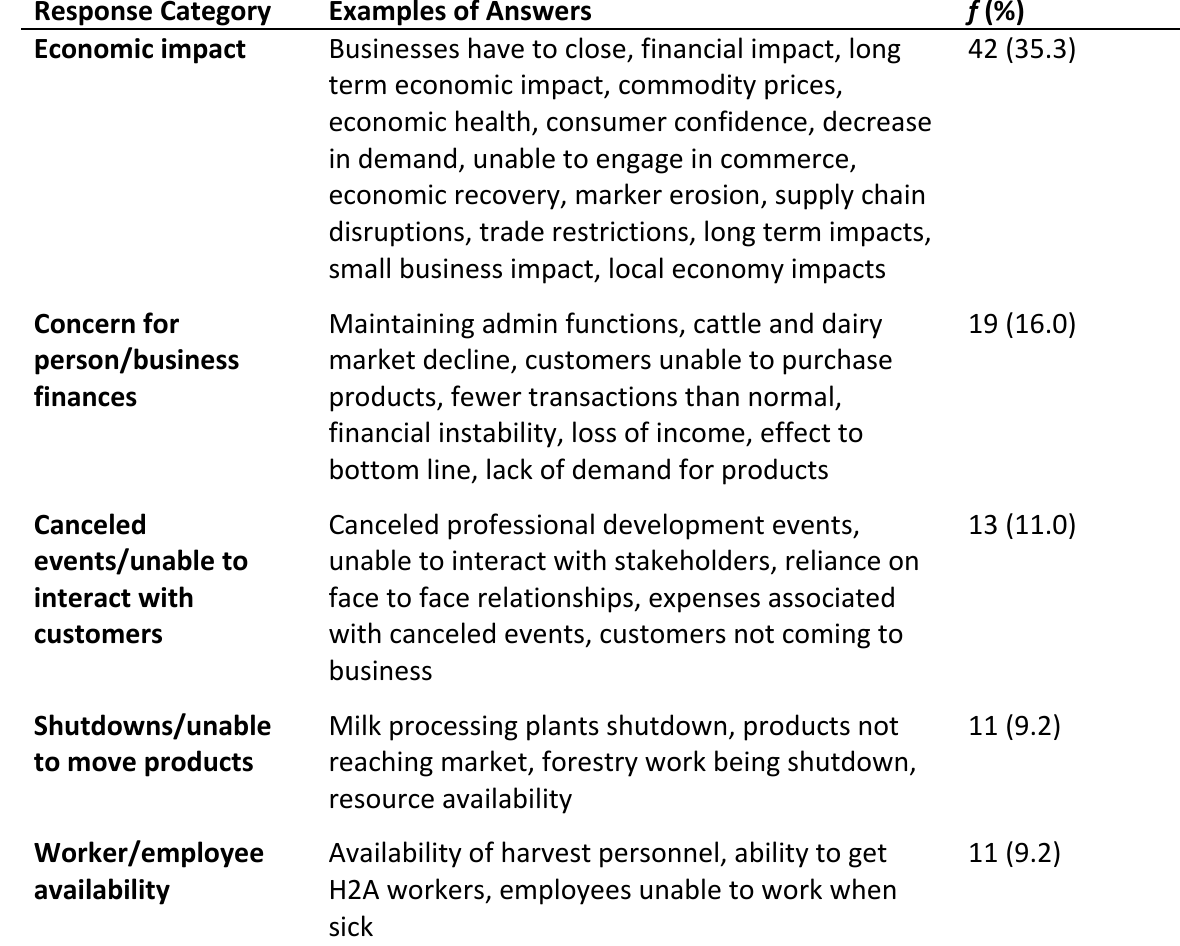
Table 8 Other Concerns and Impacts of COVID-19 Experienced by ANR Business Owners (f = 119) Response